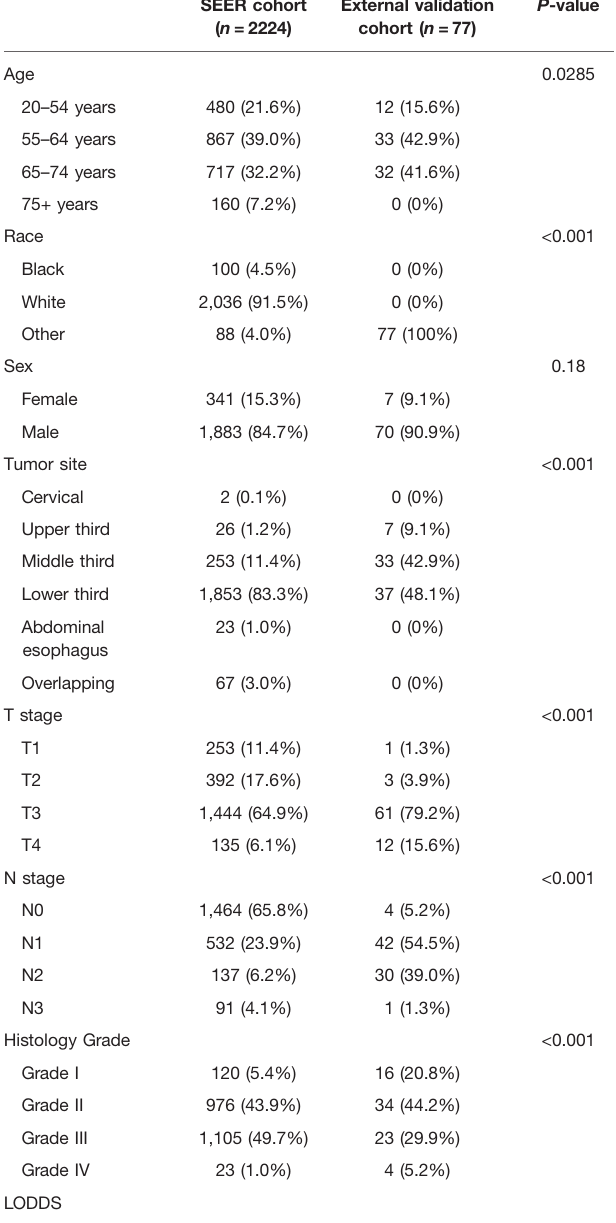
TABLE 2 | Demographics and clinicopathological characteristics of the SEER and external validation